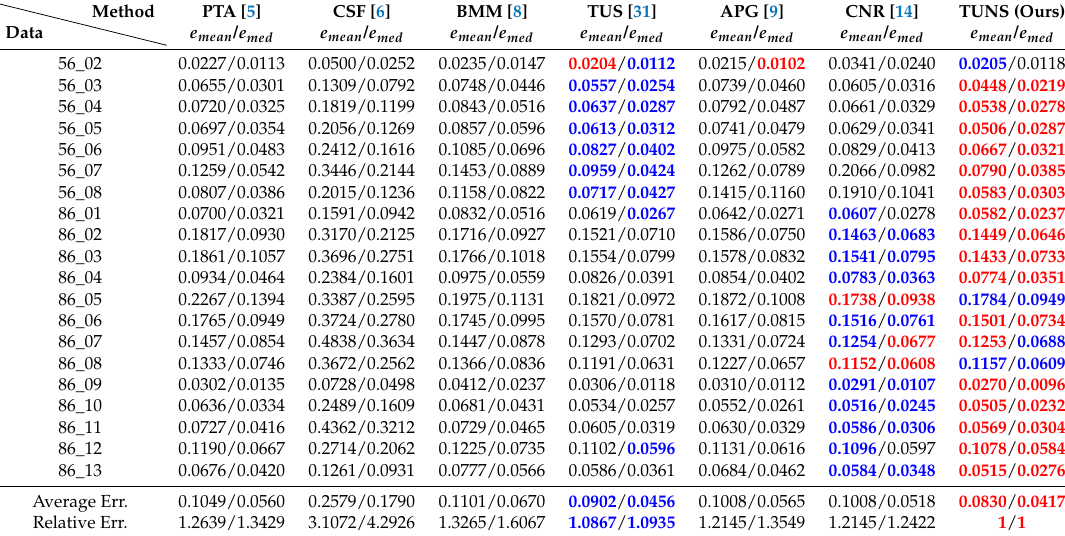
Table 1. Quantitative evaluation on CMU motion capture sequences. The table reports the mean error e mean and median error e med of 3D reconstructions for the following NRSfM baselines: PTA [5], CSF [6], and the second-best results of, both mean and median errors, are shown in red and blue ,